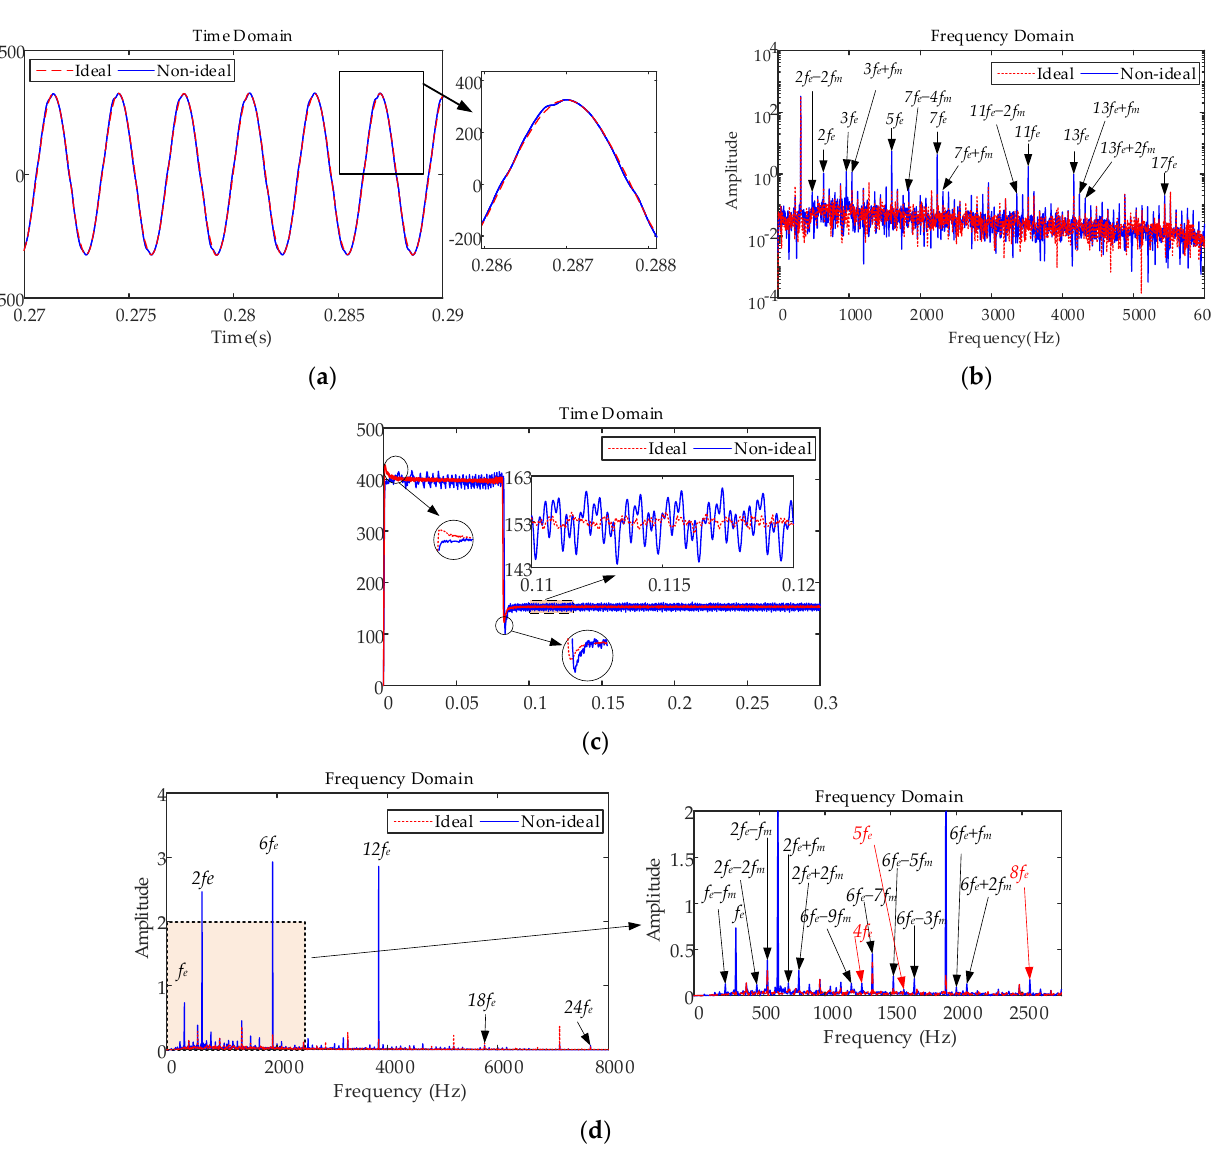
Figure 24. Comparison results of current and electromagnetic torque: ( a ) time domain of A ‐ phase current; ( b ) frequency domain of A ‐ phase current; ( c ) time domain of electromagnetic torque; ( d ) frequency domain of electromagnetic torque.